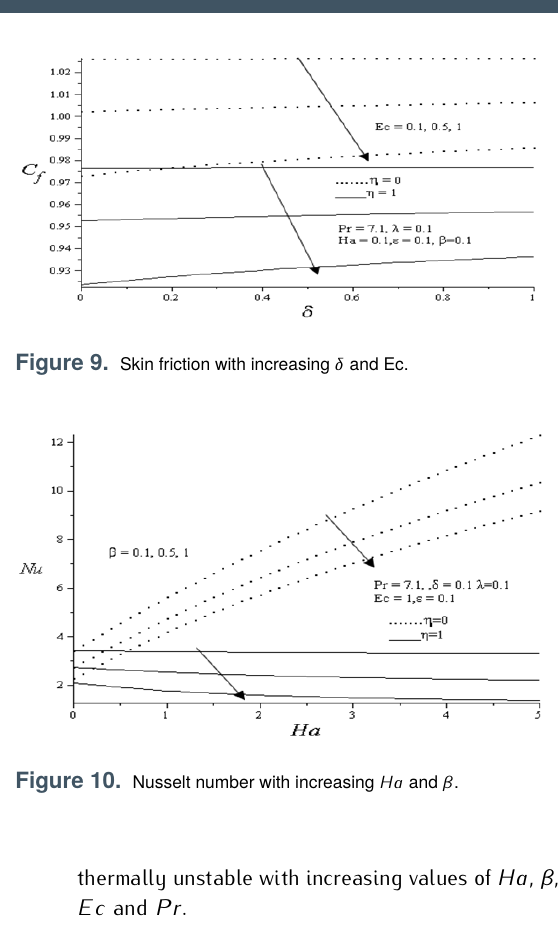
thermally unstable with increasing values of Ha , β , Ec and Pr .